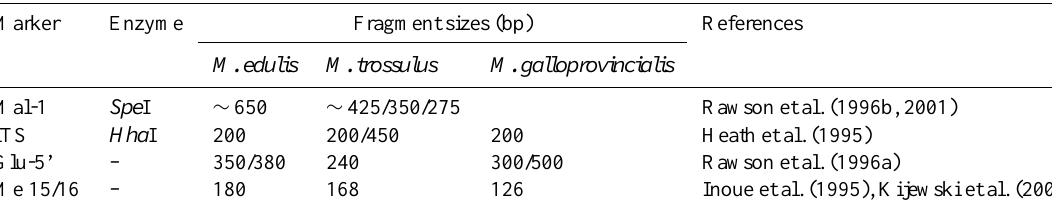
Table 2. PCR-based nuclear markers for Mytilus .